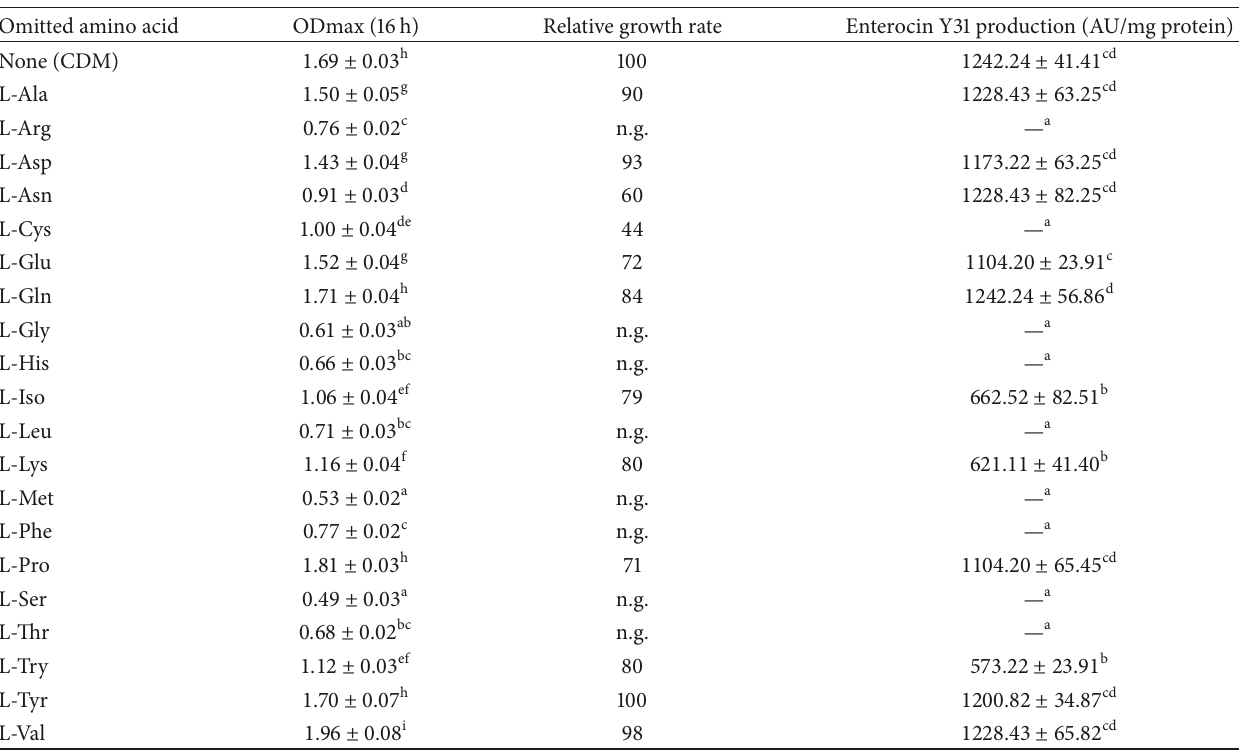
Table 3: Effect of omitting a single amino acid on the growth of Enterococcus faecium Y31 and Enterocin Y31